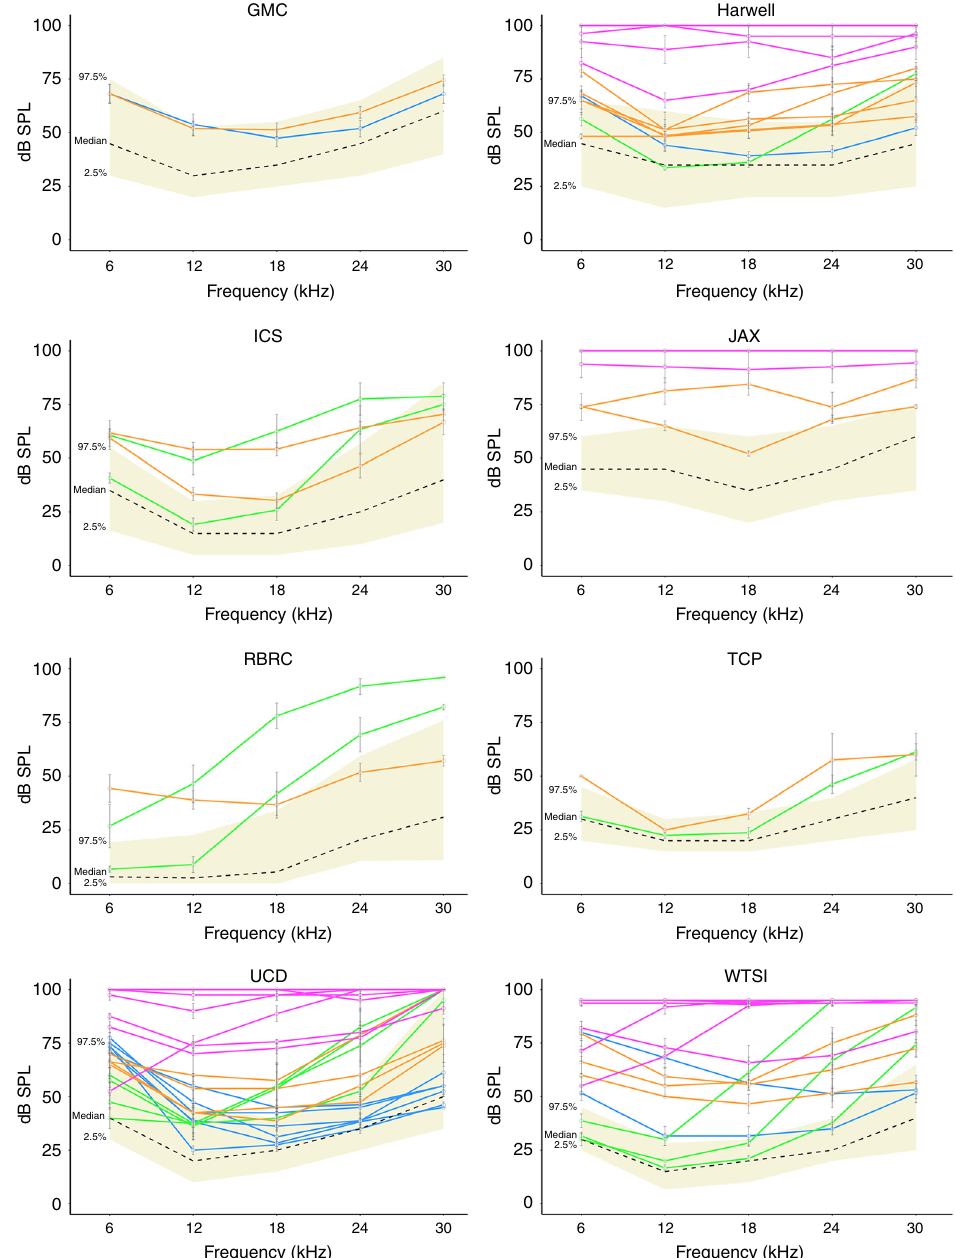
Fig. 1 Summary audiograms for hearing loss genes identi fi ed by individual IMPC centres. At each centre auditory thresholds (dB SPL) were assessed at fi ve frequencies — 6, 12, 18, 24 and 30 kHz. Each graph, displaying the data from a single IMPC centre, portrays a reference range ( yellow shaded area ) and median ( dashed line ) for control wild-type animals. The colour of each audiogram line relates to the classi fi cation of hearing loss as shown in Fig. 2 and listed in Table 1. Severe, magenta ; mild, orange ; high frequency, green ; low frequency, blue . Phenotyping centres: GMC, Helmholtz Zentrum Munchen; Harwell, MRC Harwell; ICS, Institut Clinique de la Souris; JAX, Jackson Laboratories; RBRC, RIKEN Tsukuba Institute, BioResource Center; TCP, The Centre for Phenogenomics; UCD, University of California, Davis; WTSI, Wellcome Trust Sanger Institute NATURE COMMUNICATIONS | 8: